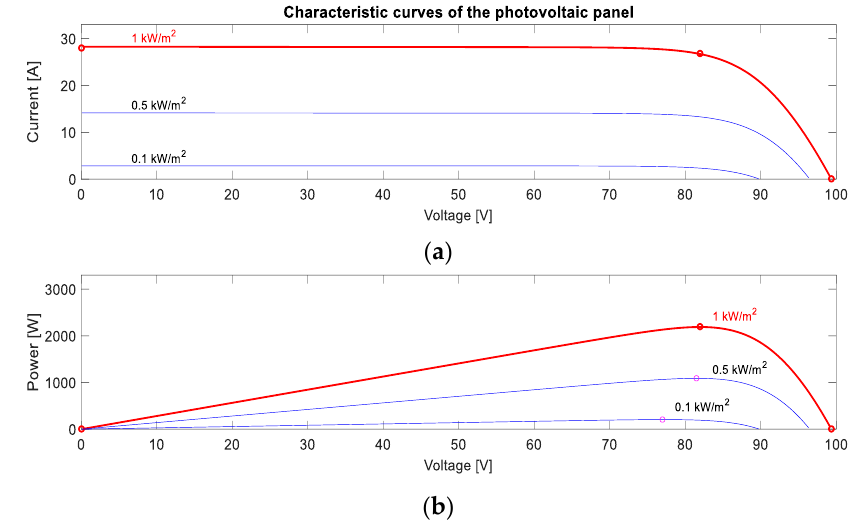
Figure 4. Characteristic curves of the photovoltaic panel: ( a ) I-V curve; ( b ) P-V curve.